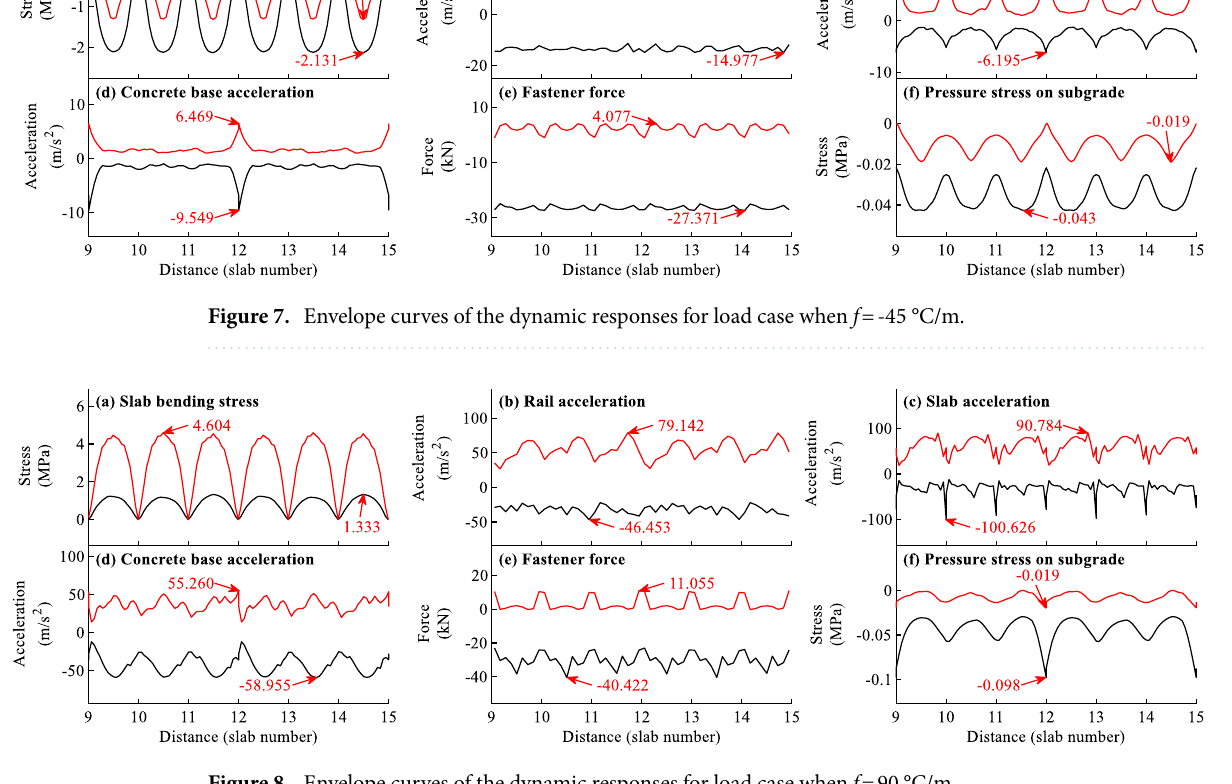
Figure 8. Envelope curves of the dynamic responses for load case when f = 90